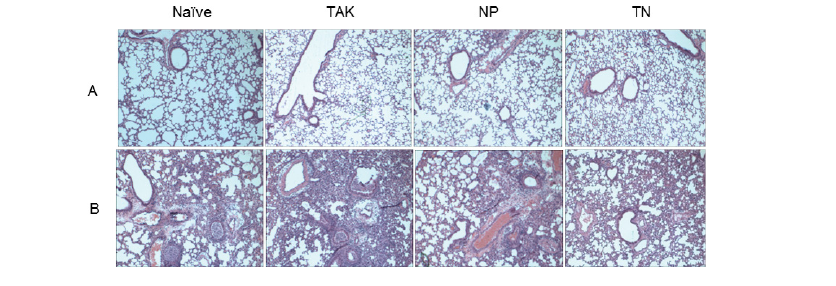
Figure 9. Lung histopathology of the lungs of control mice and mice immunized twice with NP and treated with or without TAK-779. Mice were immunized twice with NP and treated with or without TAK-779 as scheduled. Two weeks after TAK-779 cessation, mice were challenged with 10 LD50 of H1N1 (A/FM/1/47). At 3 d post–viral challenge, all in- fected mice displayed significant perivascular and peribronchial inflammation, pulmo- nary edema and necrotizing bronchitis. Forty fields were analyzed per group ( > 5 fields/ section, 2 sections/mouse). Representative sections are shown. The data were represen- tative of 2 independent experiments with 5 mice per